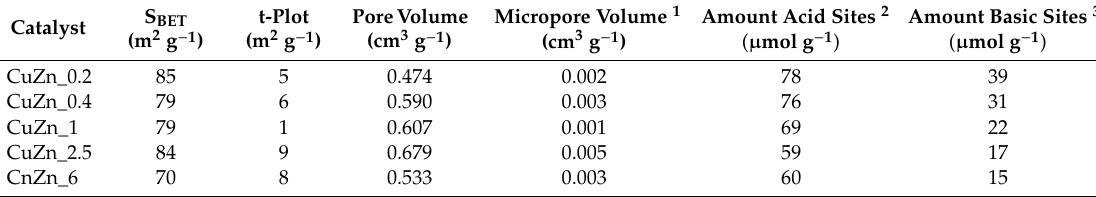
Table 2. Textural properties of the CuZn_X catalysts.